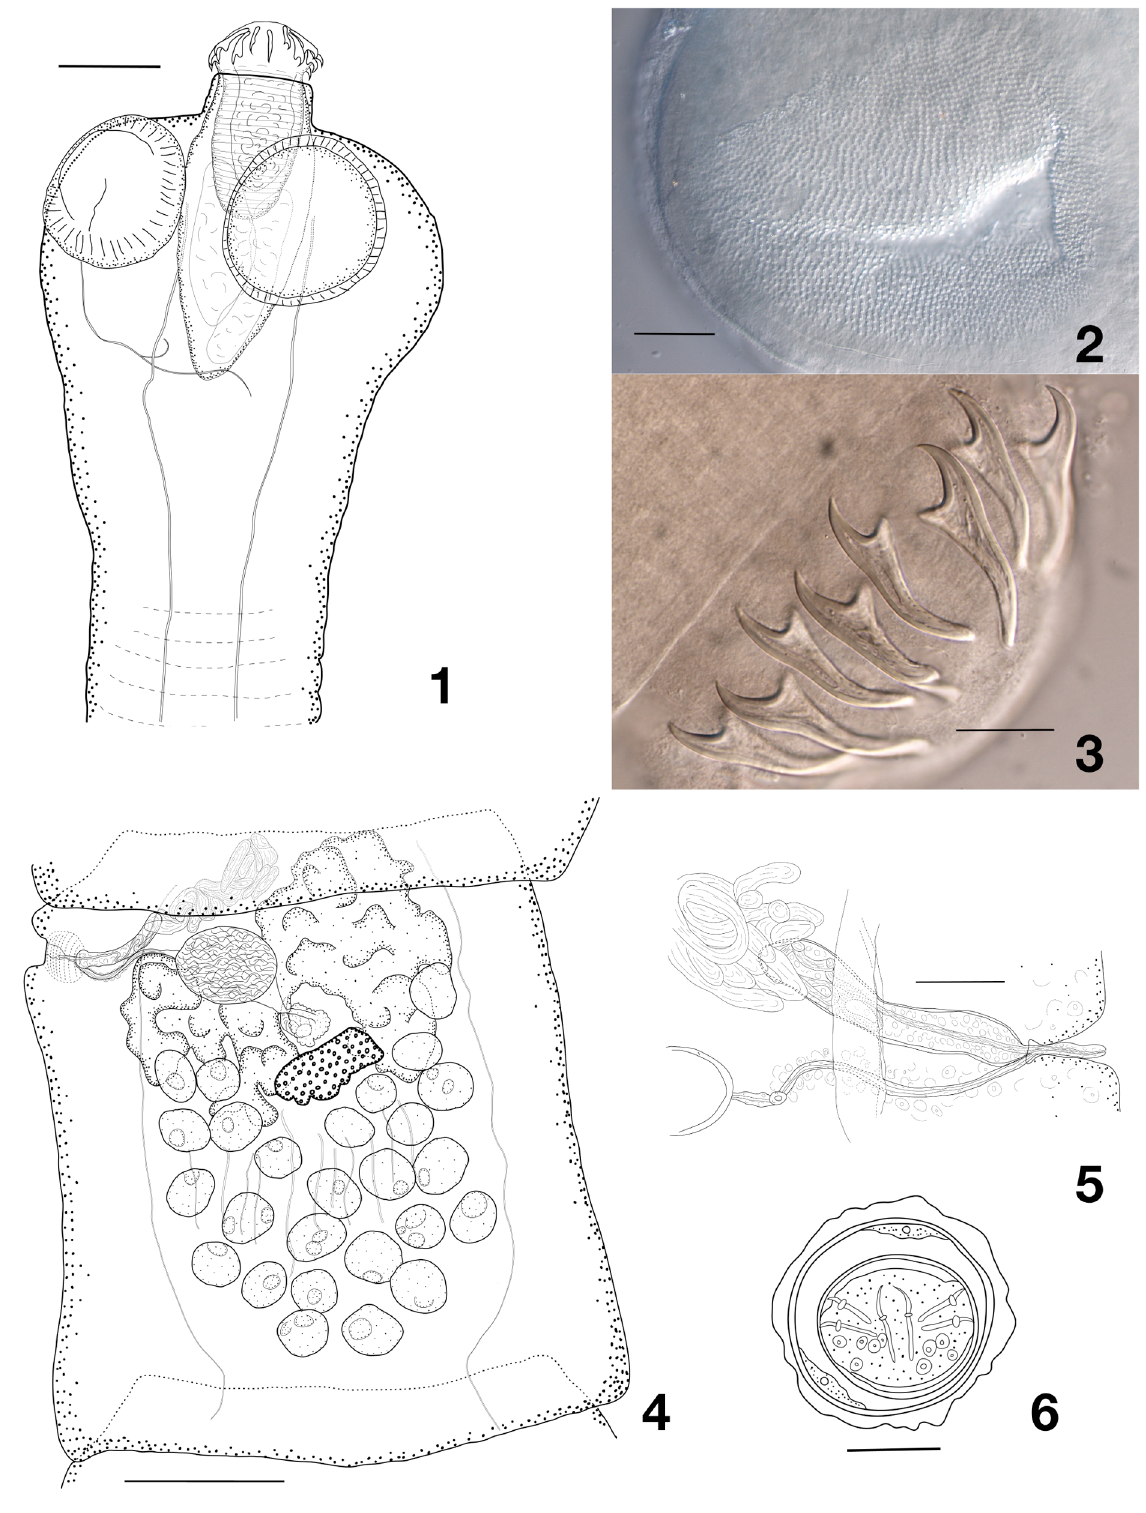
Figs 1–6. Sobolevitaenia whittingtoni sp. nov. 1 . Scolex. 2 . Sucker armament. 3 . Hooks. 4 . Mature proglottis. 5 . Terminal genitalia. 6 . Egg. Scale bars: 1 = 100 µm; 2, 5 = 50 µm; 3, 6 = 20 µm; 4 = 250